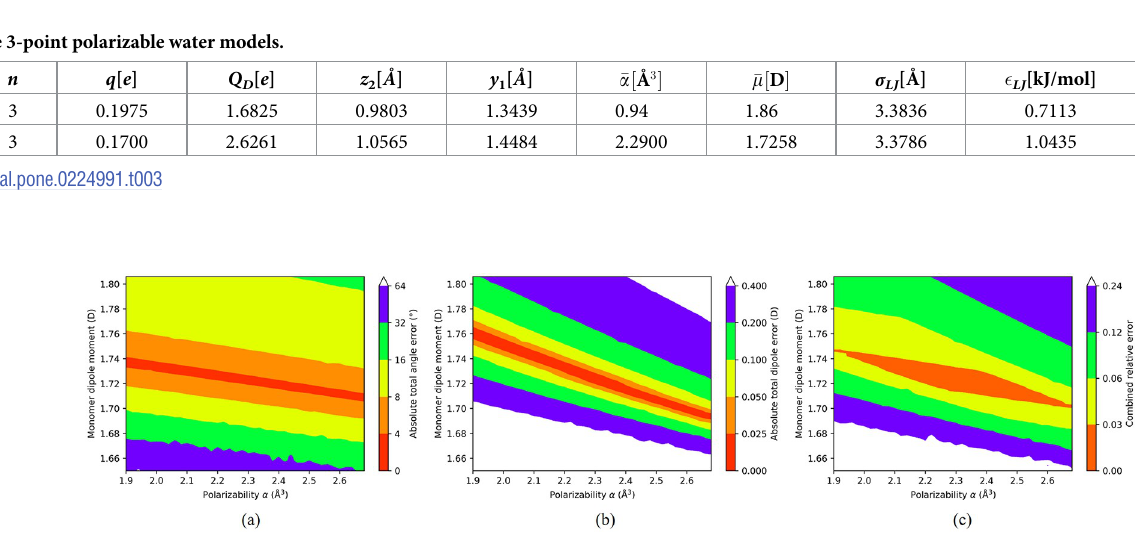
Fig 8. Globally optimal polarizable model error distribution. (a) The absolute error of the total angle ( θ + φ ) as a function of the corresponding model’s monomer dipole μ and polarizability α value. (b) The water dimer total dipole moment error with respect to the model’s μ , α combination. (c) The approximate range of the optimal μ , α combinations, where the “combined relative error” is defined as Error = Error /180˚ + Error / p with p = 2.68D [38]. The “combined relative error” was not used in combined angle dipole dimer dimer the actual optimization process.